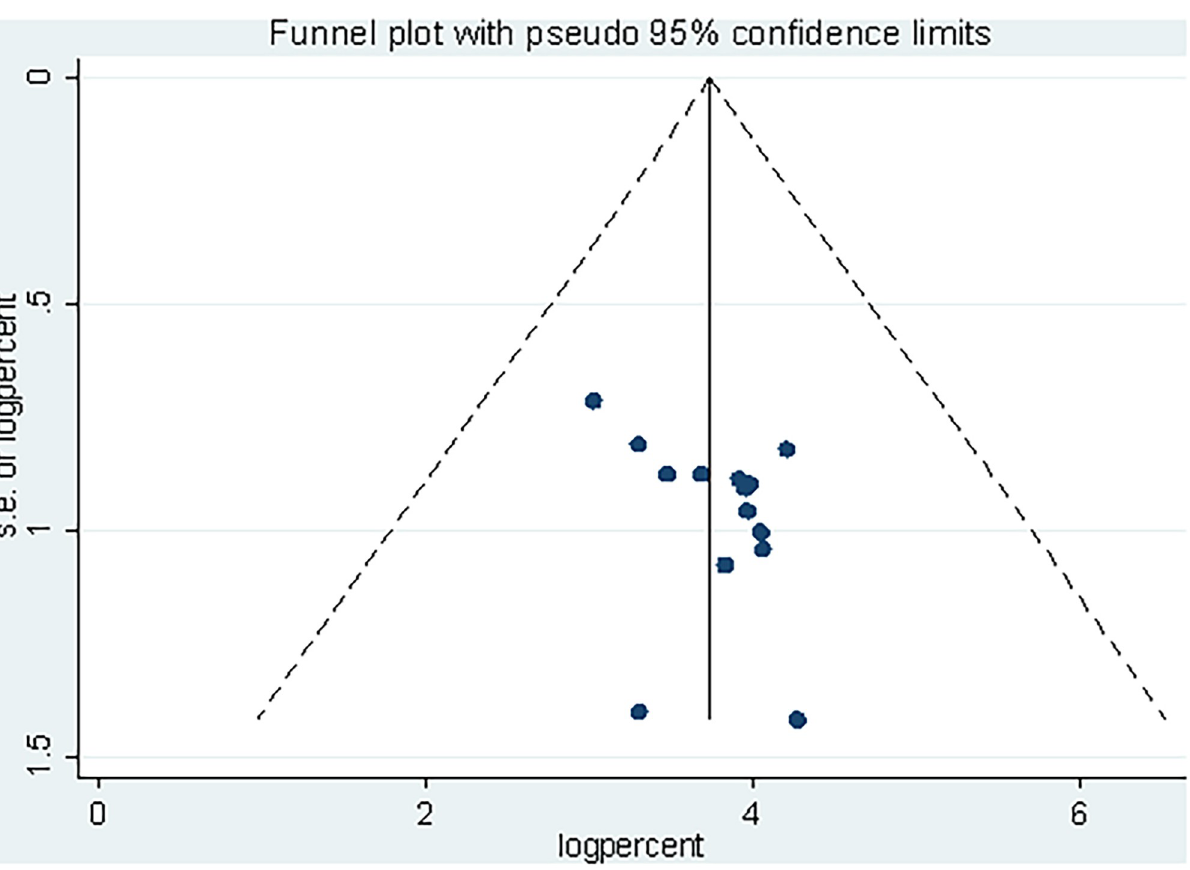
Fig 5. Funnel plot showing publication bias of food handling practice studies among food handlers in public food establishments of Ethiopia, 2022.